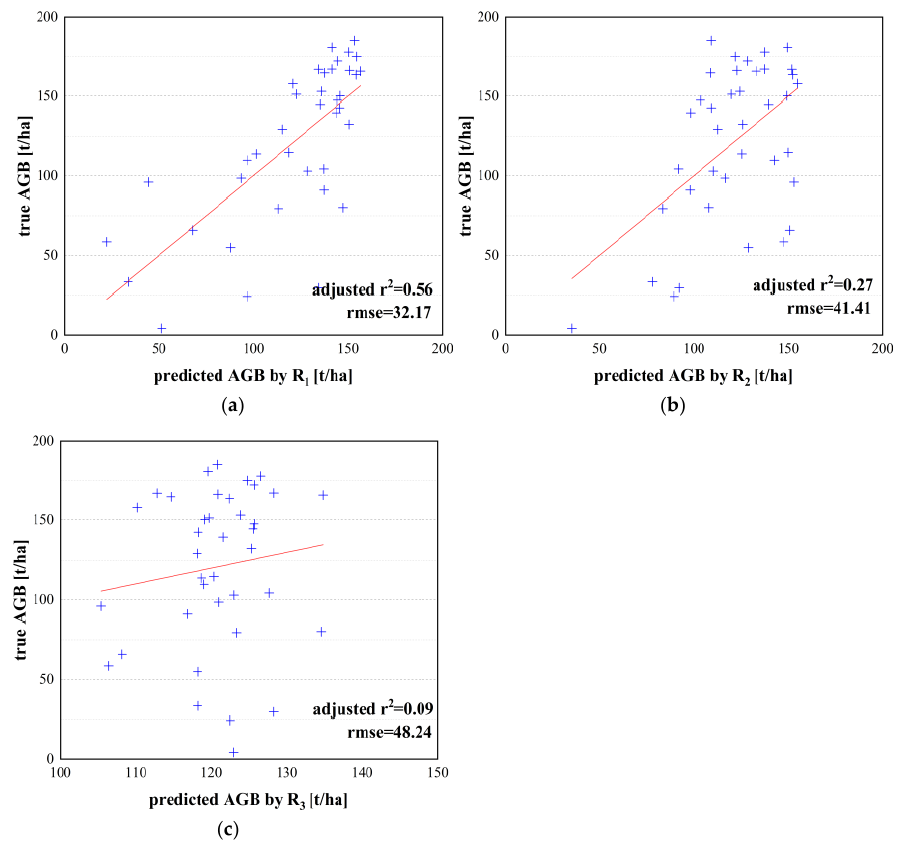
Figure 6. ( a ) Models established by R 1 and AGB; ( b ) models established by R 2 and AGB; ( c ) models established by R 3 and AGB.